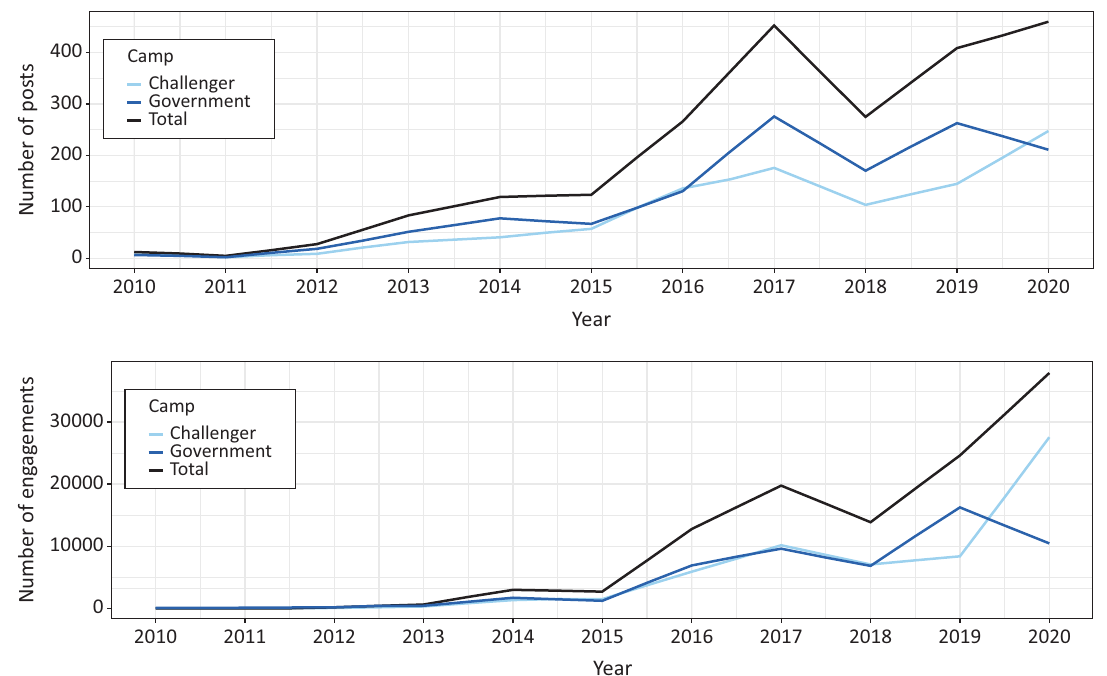
Figure 2. Developments of the number of Facebook posts and generated engagements by camp over